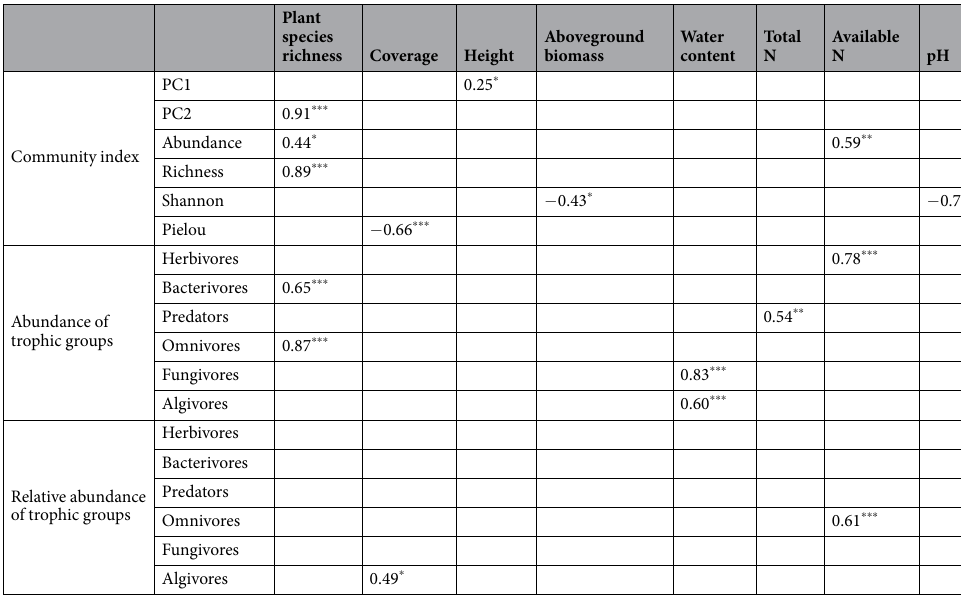
Table 5. The partial correlation coefficients of multiple regression analyses (stepwise procedure) between soil nematode communities and environmental factors (n = 24). The superscript stars *** , ** and * indicate significant correlations at the 0.001, 0.01 and 0.05 levels,